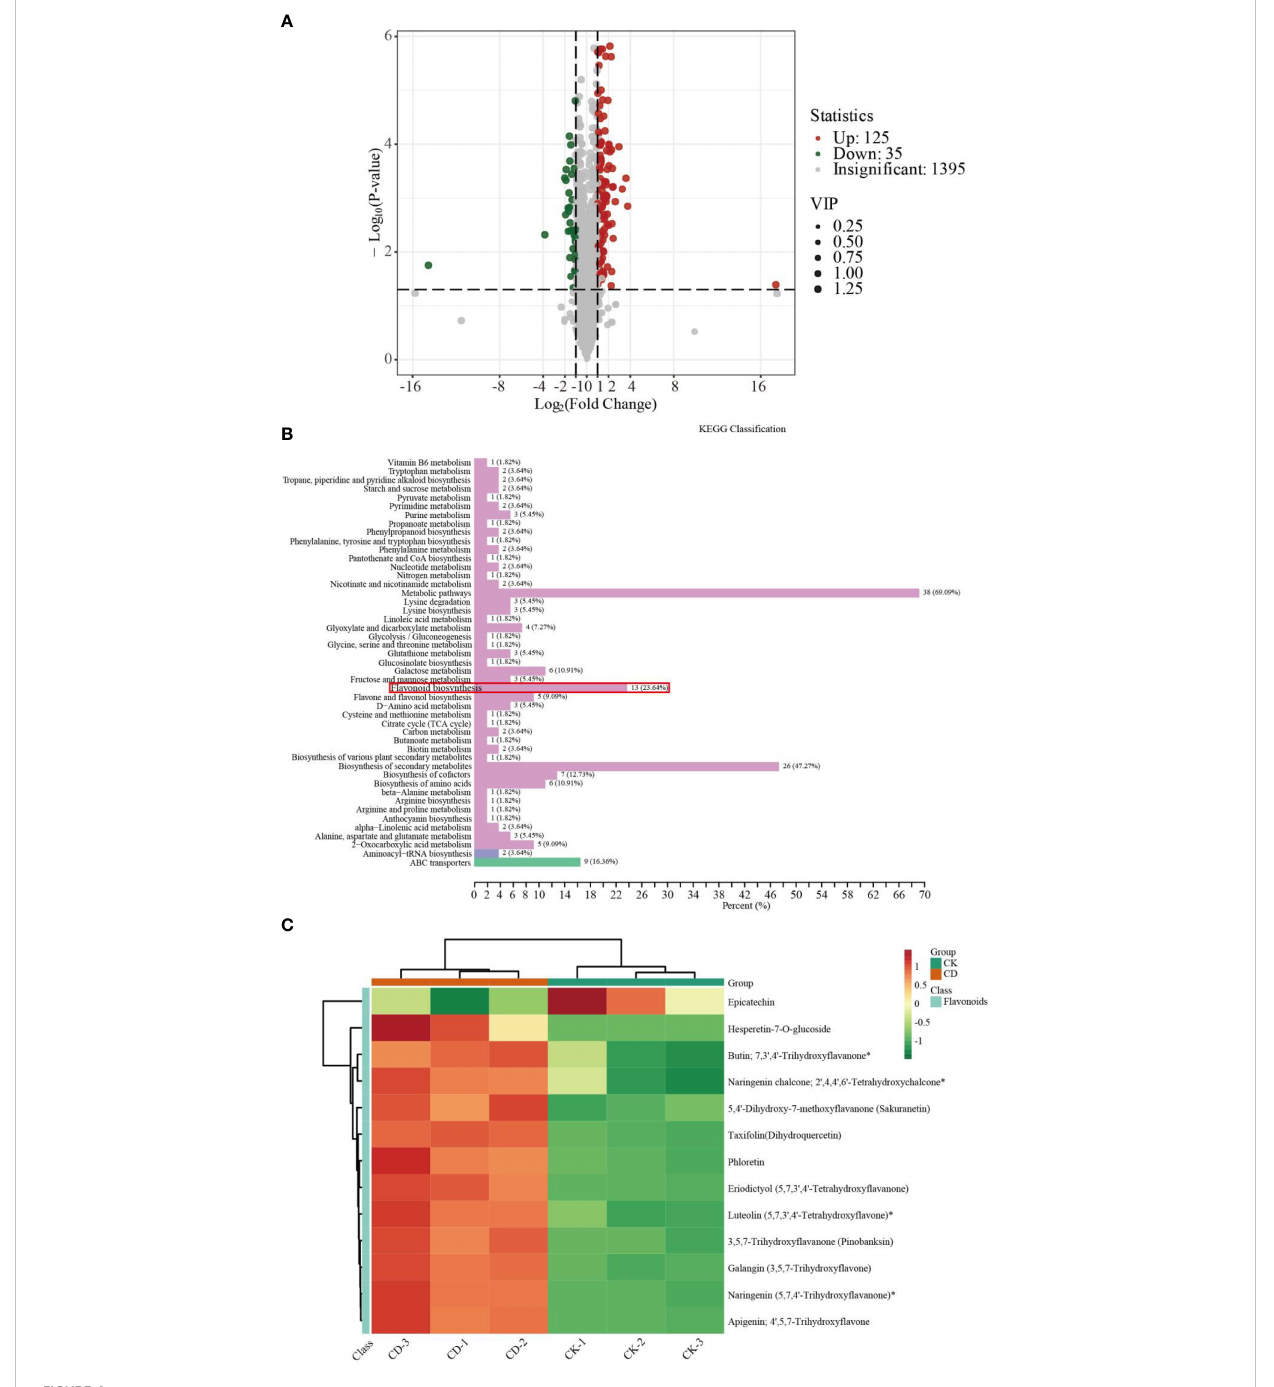
FIGURE 4 Metabolite analysis of sorghum roots under 0 and 10 m M Cd treatments. (A) Volcano plots of DEMs. (B) KEGG classi fi cation of DEMs. (C) Heat map of DEGs in fl avonoid biosynthesis